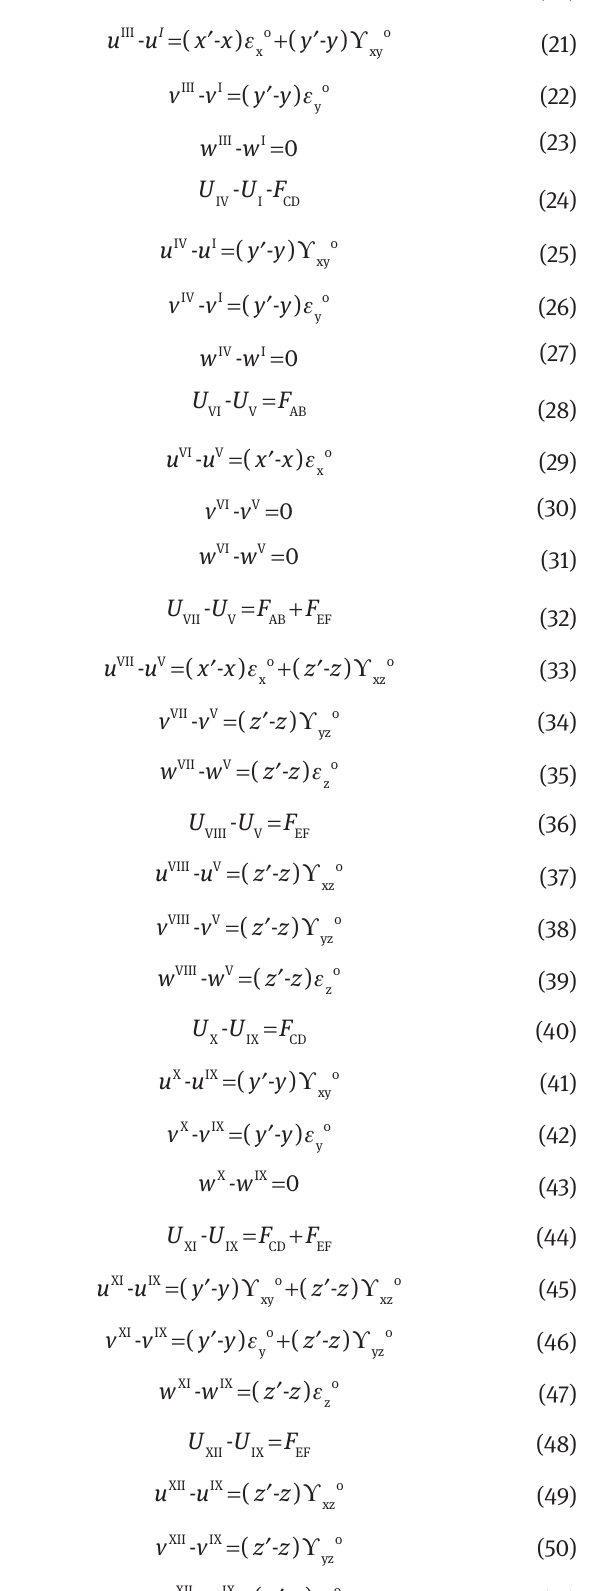
Figure 11: Schematic representations of the edges